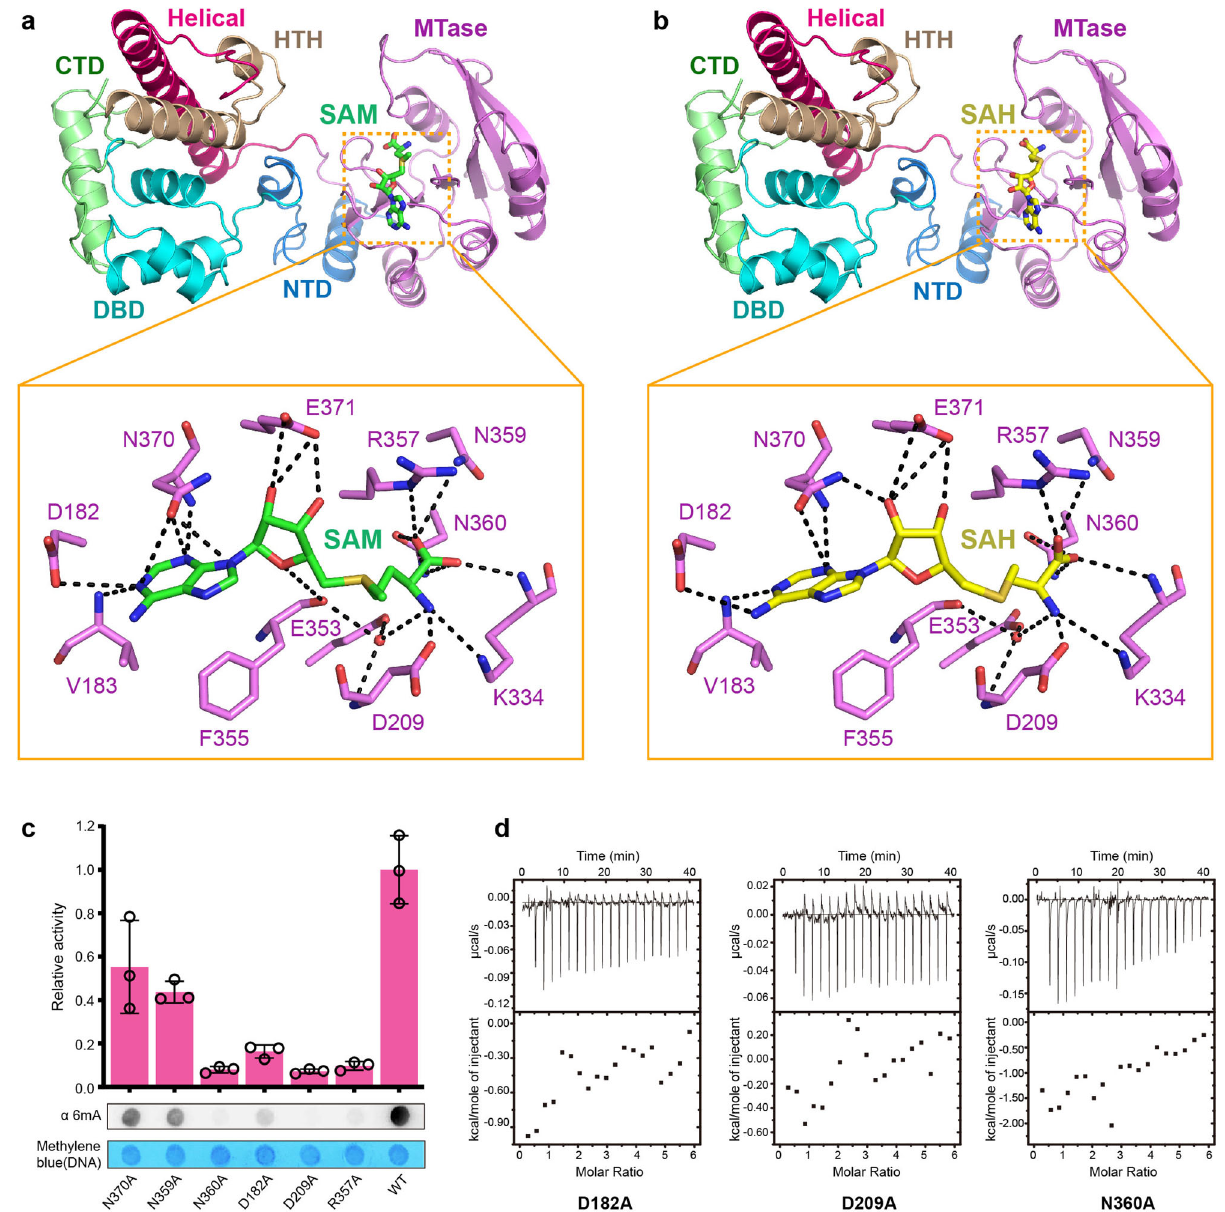
Fig. 4 Recognition of the cofactor substrate. a Detailed interactions between SAM and MTase domain of TthMTA1. Residues involved in SAM binding are shown as violet sticks. SAM is shown as green sticks. Water is shown as red spheres. Hydrogen bonds are shown as black dashed lines. b Detailed interactions between SAH and MTase domain of TthMTA1. Residues involved in SAH binding are shown as violet sticks. SAH is shown as yellow sticks. Water is shown as red spheres. Hydrogen bonds are shown as black dashed lines. c Antibody-based methyltransferase activity of the TthMTA1c complexes with indicated MTA1 point mutations. Each mutation does not affect MTA1-MTA9-p1-p2 complex formation. Each MTA1-MTA9-p1-p2 mutant complex used for enzymatic assay was expressed and puri fi ed as MTA1-MTA9-p1-p2 WT complex. A 954-bp dsDNA PCR product was sued as the substrate. Data are shown as mean ± SD from n = 3 independent experiments; open circles indicate values for individual repeat measurements. d ITC assay of the TthMTA1c complexes with indicated MTA1 point mutations. Each MTA1-MTA9-p1-p2 mutant complex used for ITC assay was puri fi ed as MTA1- MTA9-p1-p2 WT complex. Source data for ( c ) are provided in a Source Data fi